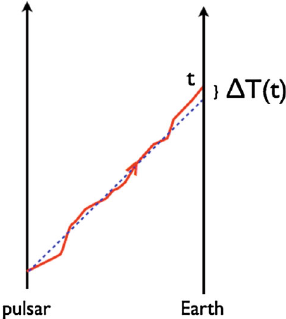
Fig. 22 A spacetime diagram representation of Δ T ( t ) for a (one-way) pulsar timing residual measurement. Time increases vertically upward. The vertical arrows are spacetime worldlines for a pulsar and a detector on Earth. The measurement is made at time t . The blue dotted line shows the trajectory of the radio pulse in the absence of a gravitational wave; the red solid line shows the trajectory in the presence of a gravitational wave the phase difference can be calculated in terms of the change in the round-trip travel time of the laser light from one test mass (e.g., the beam splitter) to another (e.g., one of the end test masses). If we consider an equal-arm Michelson interferometer with unit vectors ˆ u and ˆ v pointing from the beam splitter to the end masses in each of